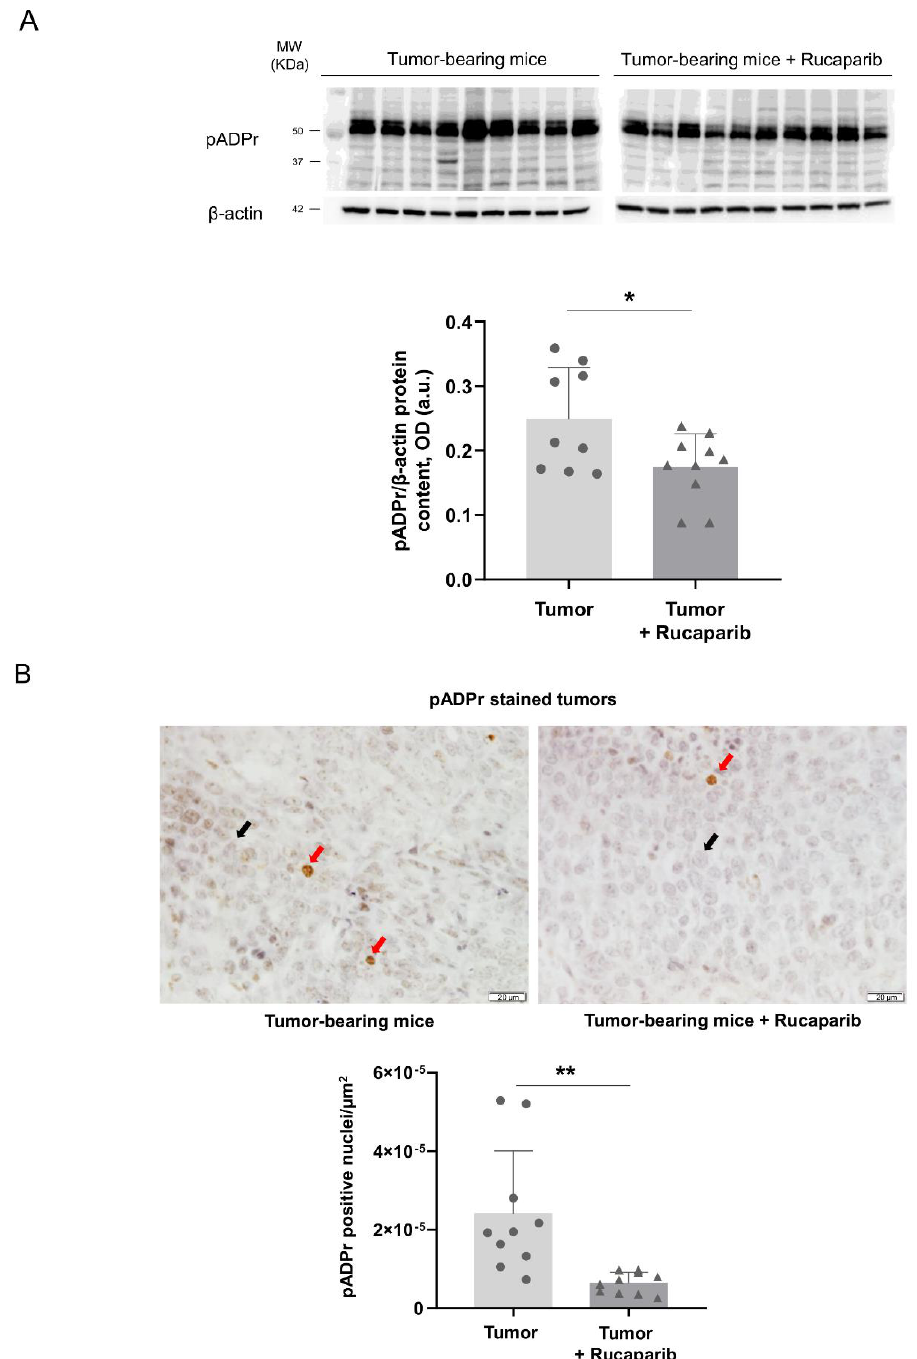
Figure 1. ( A ) Representative immunoblots of pADPr polymers and β -actin proteins in the tumors of both study groups ( top ) and mean values and standard deviations of pADPr protein content ( bottom ). ( B ) Representative examples of nuclei positively stained for poly-ADPr (red arrows point towards brown nuclei) and not stained (black arrows point towards blue nuclei, hematoxylin counterstaining) in tumors of both experimental groups ( top ) and mean values and standard deviations of positively stained nuclei for pADPr in the total measured area ( bottom ). In the scatter plot, the circles represent the untreated tumor-bearing mice while the triangles represent the rucaparib treated tumor-bearing mice. Statistical significance: * p ≤ 0.05, ** p ≤ 0.01 between tumor-bearing mice treated with rucaparib and non-treated tumor-bearing mice. Definition of abbreviations: pADPr, poly-ADP ribose; OD, optical densities; a.u., arbitrary units. Scale bar = 20 µ m, 40 ×